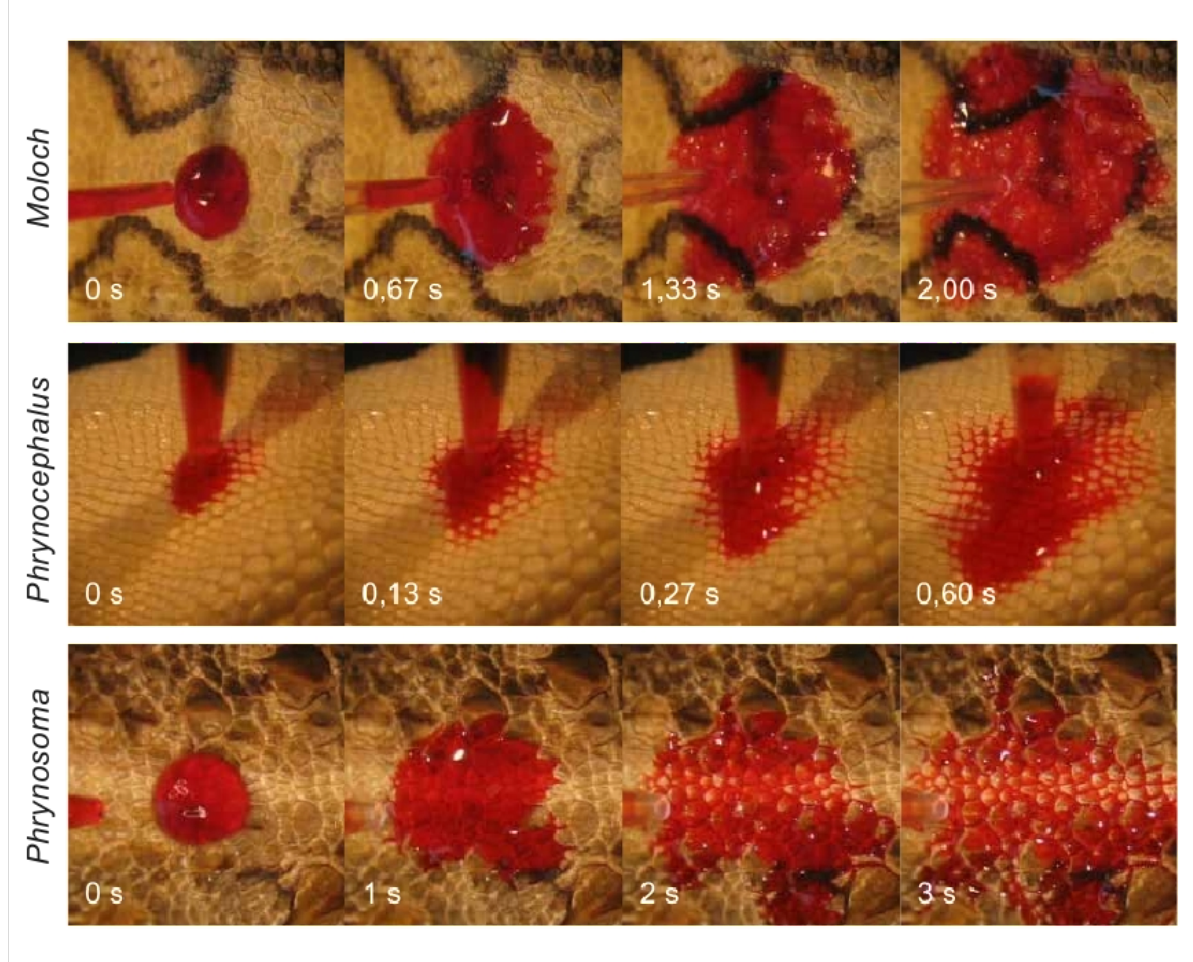
Figure 8: Water transport in interscalar capillaries. The behaviour of coloured water on the integument of the three investigated lizards is shown. The mouth is always located to the right. Note the colouring of the interscalar capillaries, best seen for Phrynocephalus . While the transport is about symmetrical for Moloch and Phrynocephalus , the velocity of the water transport is highest in direction to the mouth on Phrynosoma .